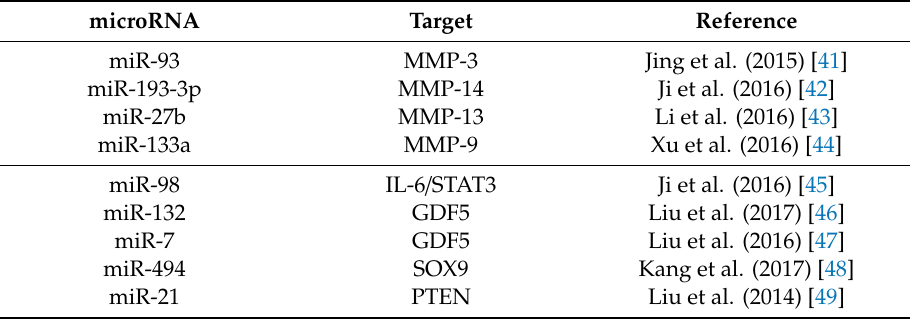
Table 1. microRNAs associated with ECM degradation in DDD and their corresponding targets. MMP: matrix metalloproteinases; IL-6 / STAT3: interleukin-6 / signal transducer and activator of transcription 3; GDF5: growth di ff erentiation factor 5; SOX9: SRY-box transcription factor 9; PTEN: phosphatase and tensin homolog